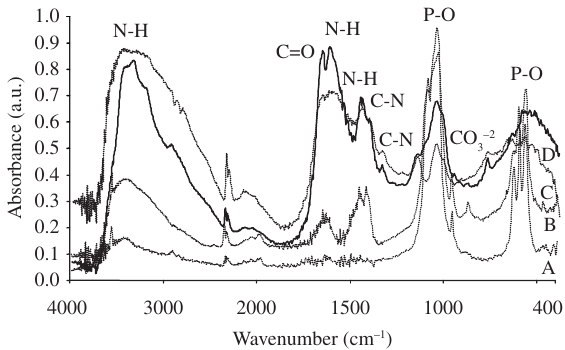
Figure 6. FTIR spectra of (A) HAP b TCP and (B) HAP showing the pres- ence of bands corresponding to groups PO 43– at 600 and 1100 cm –1 ,